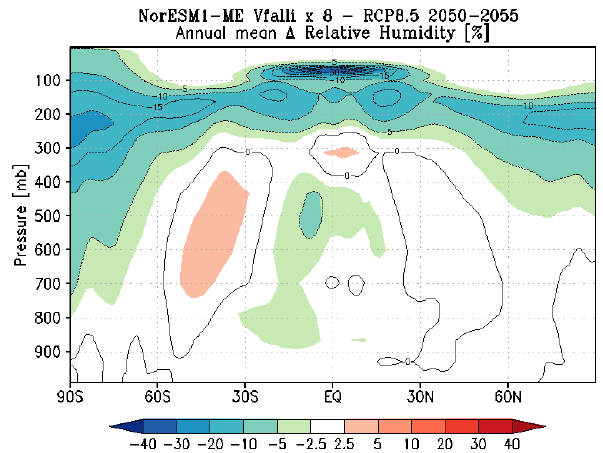
Figure 6. Schematic of experiment G7cirrus. Against a background scenario of the ScenarioMIP Tier 1 high forcing scenario, a repre- sentation of cirrus cloud seeding will reduce net forcing by a con- stant amount. This simulation will begin in 2020 and will be con- ducted for 80